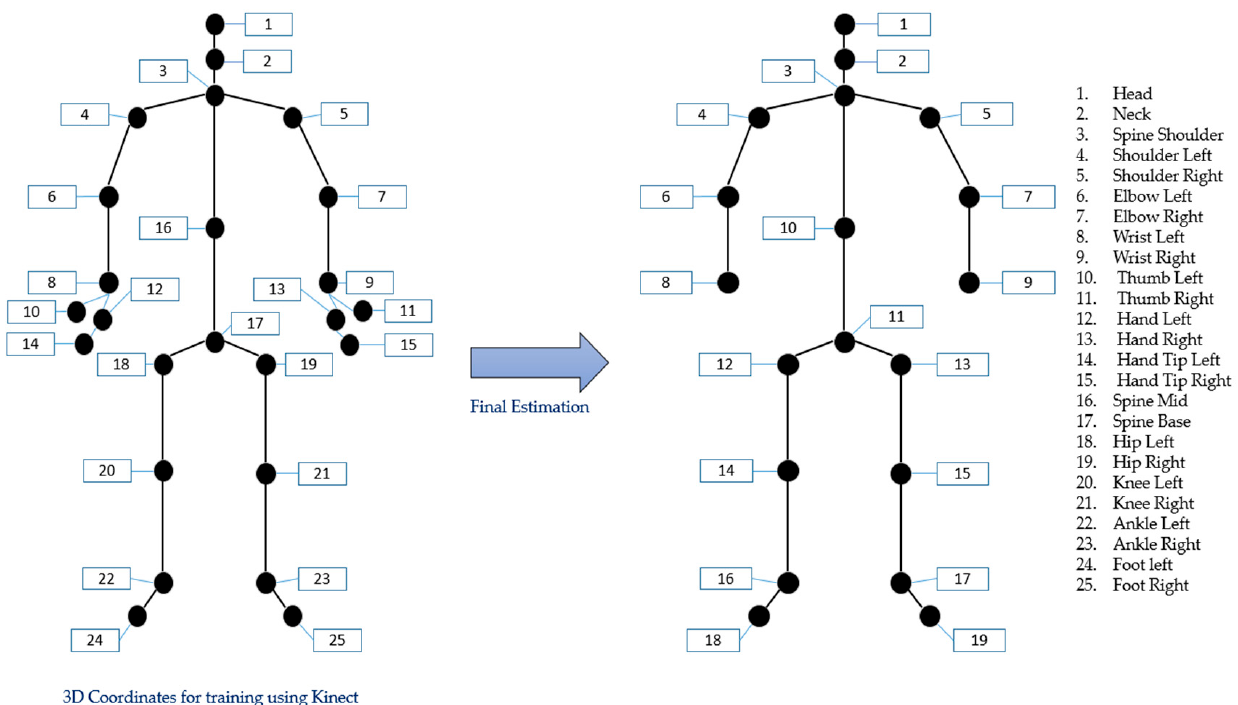
Figure 5. The training and estimated joint positions.